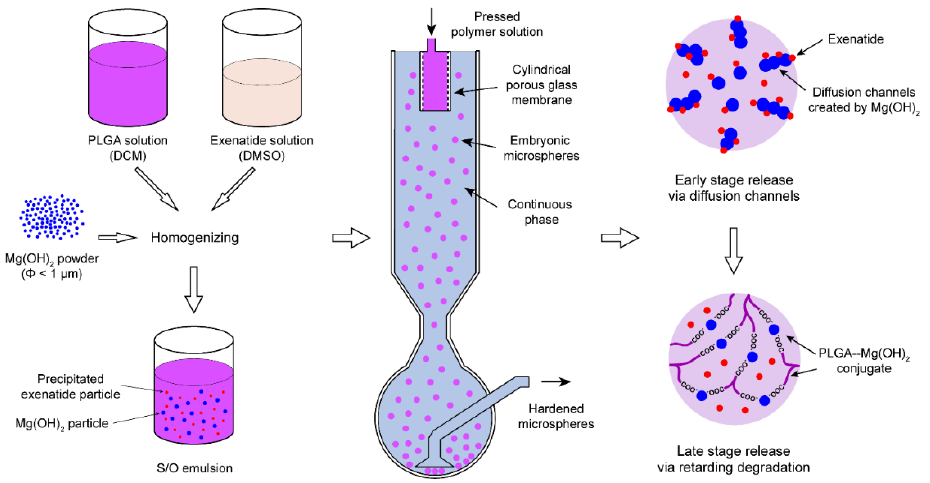
Figure 1. Schematic description of the PLGA microsphere preparation process and the mechanism of Mg(OH) 2 as a dual-functional excipient. Mg(OH) 2 as a dual-functional